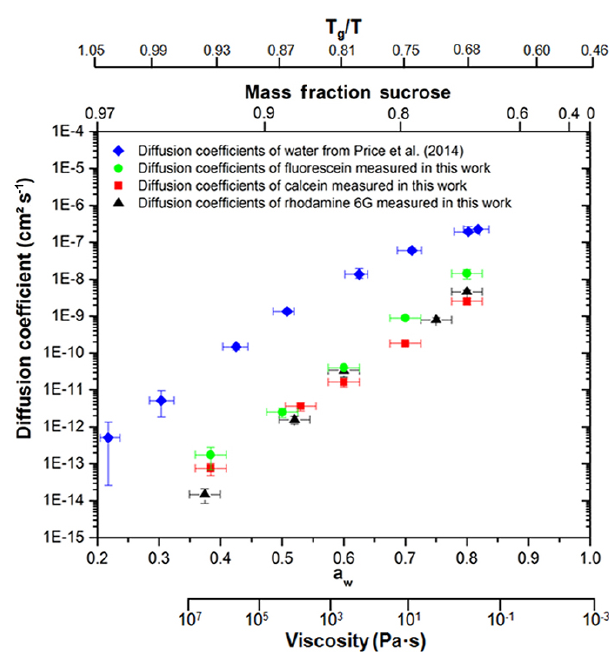
Figure 9. A comparison of the measured diffusion coefficients of fluorescein (green circles), rhodamine 6G (black triangles) and cal- cein (red squares) with the measured diffusion coefficients of water by Price et al. (2014) (blue